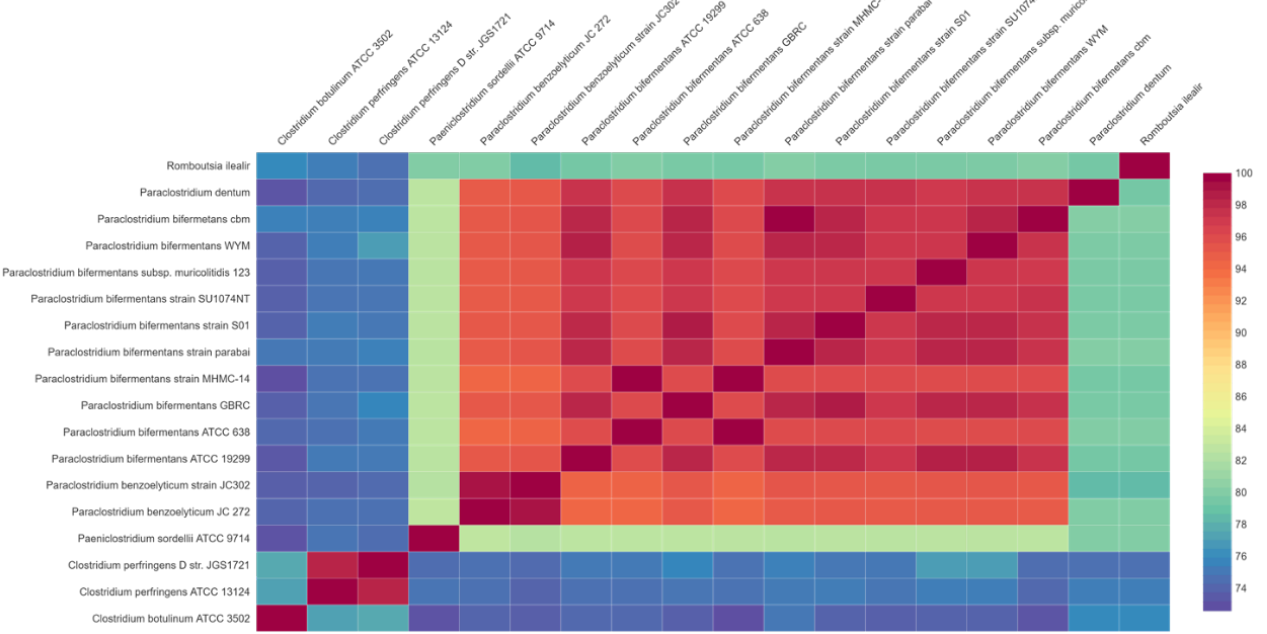
Figure 2. Relationship of P. bifermentans GBRC among other 17 closely related organisms. The average nucleotide identity (ANI) matrix was generated using ANI calculator and the enveomics collection toolbox genome was used for distance matrix calculation.